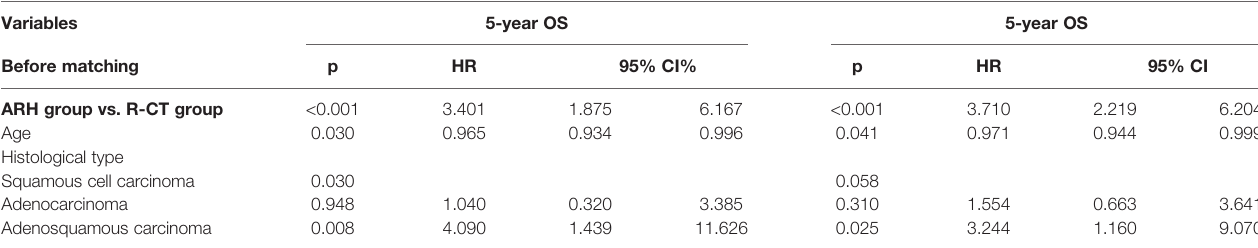
TABLE 2 | COX Multivariate analysis of the overall study population according to group.